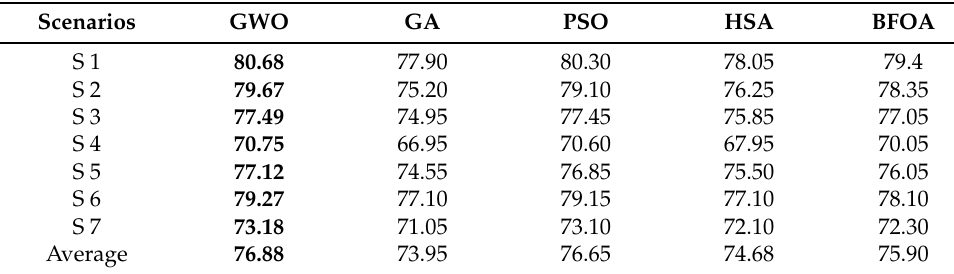
Table 17. Comparison between the five algorithms in terms of UC p